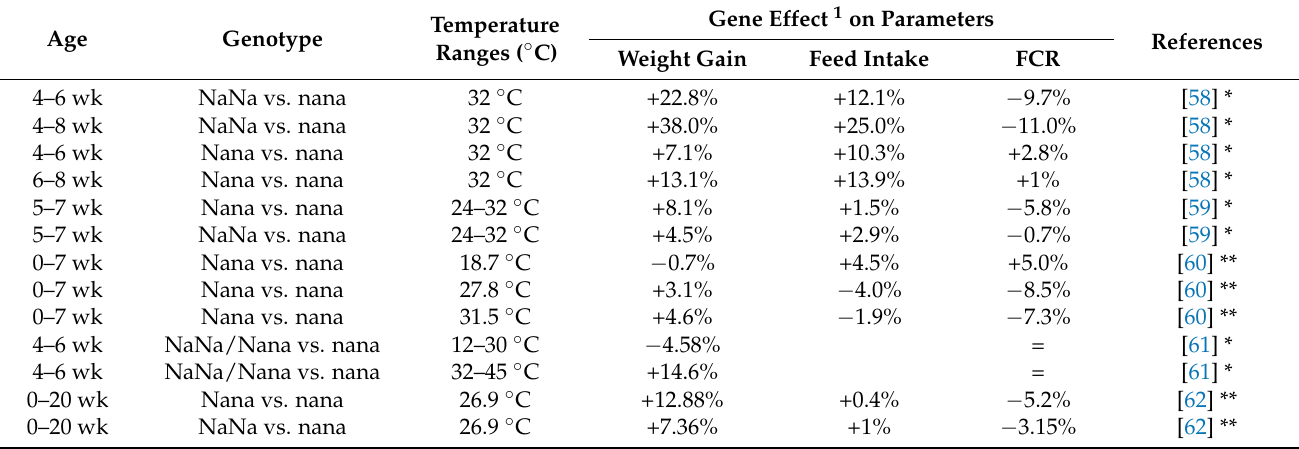
Table 1. Summary of the effects of Na gene at different ages and temperatures on weight gain, feed intake, and